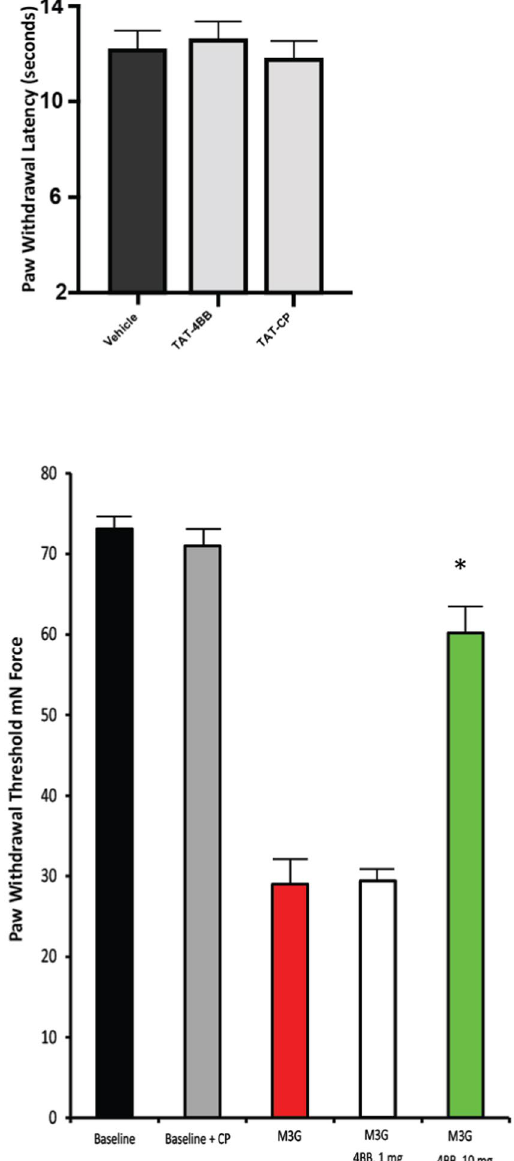
Figure 5. Effects of cell-permeable TAT-4BB decoy peptide on thermal sensitivity and tactile allodynia. ( A ) TAT- 4BB and TAT-CP was tested for the ability to alter nocifensive behavior in naïve rats. ( B ) TAT-4BB was tested for the ability to prevent sensitivity to tactile stimulus one hour after M3G administration. TAT-4BB potently affected behavioral hypersensitivity at 10 mg/kg but not 1 mg/kg. Values are the mean ± SEM of two groups of 8 rats per time point. ( ∗ = p < 0.05 TAT-4BB in combination with M3G rats compared to M3G treatment